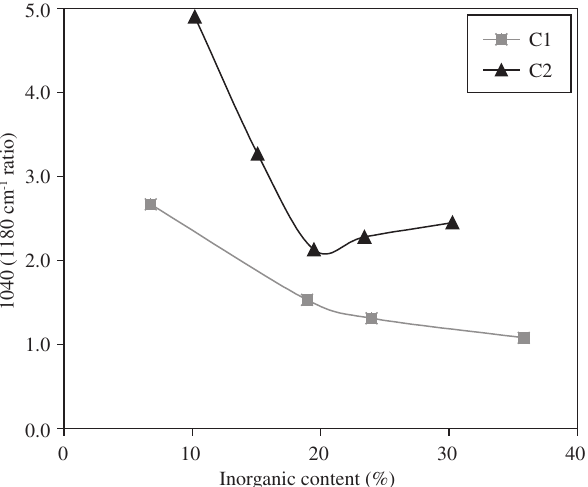
Figure 10. TGA curves of the PU-2 and inorganic modified polyurethanes derived from PU-2 (C2). In brackets: the experimental inorganic content (percent of the samples left after heating up to 900 °C). The inset shows the first derivative of TGA curves for samples PU-2 and